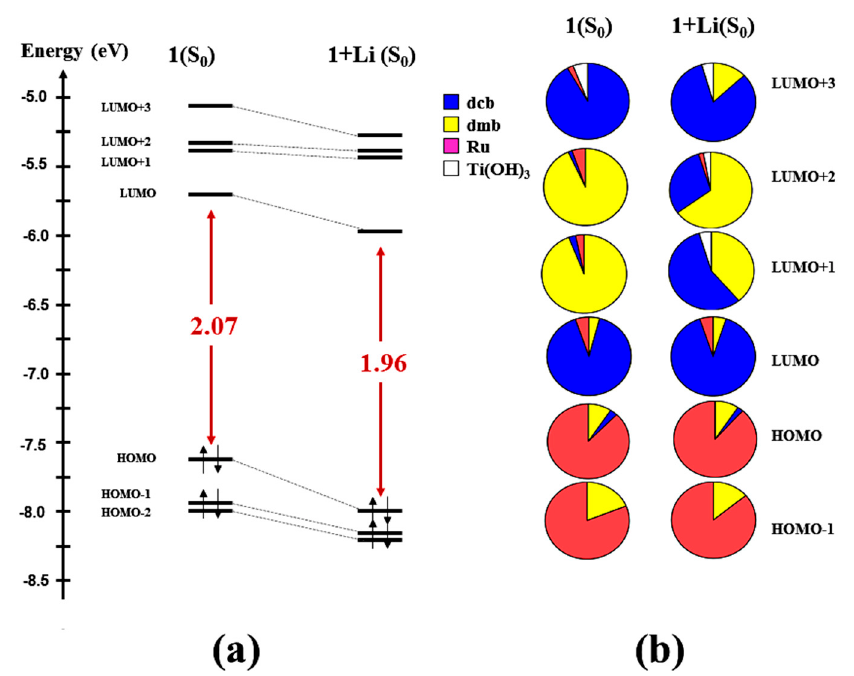
Figure 33. ( a ) Energy levels diagram for the lithium adduct. ( b ) Molecular orbital composition in terms of fragments dcb, dmb, Ru and Ti(OH) 3 .